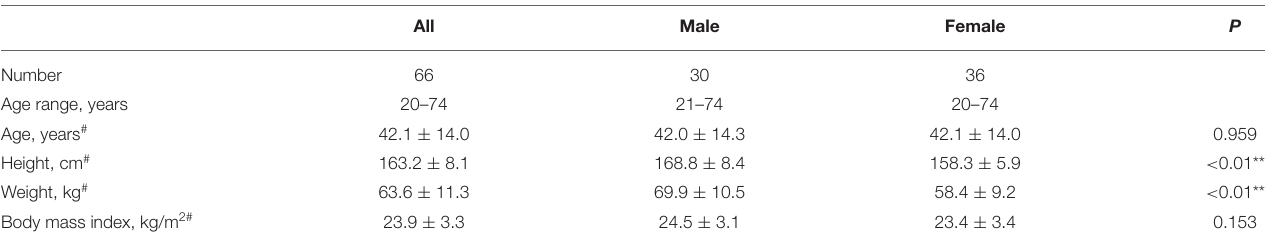
TABLE 1 | Cohort characteristics.